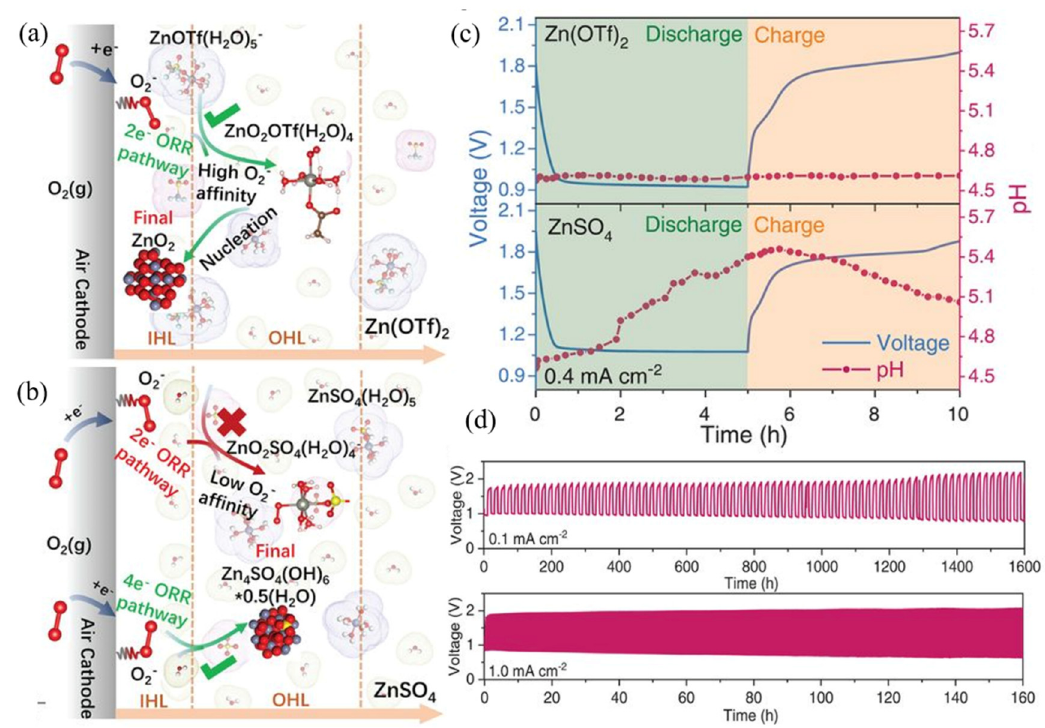
Figure 14. Schematic representation of reaction process in the inner Helmholtz layer (IHL) and outer Helmholtz layer (OHL) across the external surface of the air electrode in ( a ) Zn(OTf) 2 (two-electron) and ( b ) ZnSO 4 (four-electron) electrolytes, respectively; ( c ) Galvanostatic charge/discharge curves of Zn-air cells prepared with Zn(OTf) 2 and ZnSO 4 electrolytes at a current density of 0.4 mA/cm 2 and the corresponding noted pH values of the electrolyte, ( d ) long-duration cyclic activity of Zn-air cells at 0.1 and 1.0 mA/cm 2 current densities. [68]. Reprinted with permission from Ref. [68], Copyright 2021, AAAS.